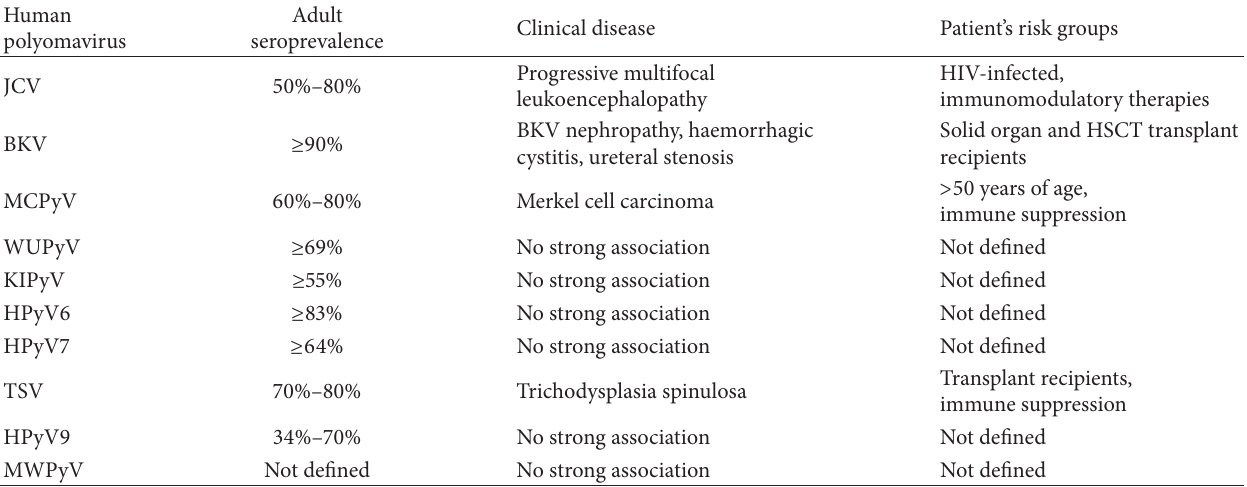
Table 1: The human polyomaviruses, associated disease and immunocompromised risk